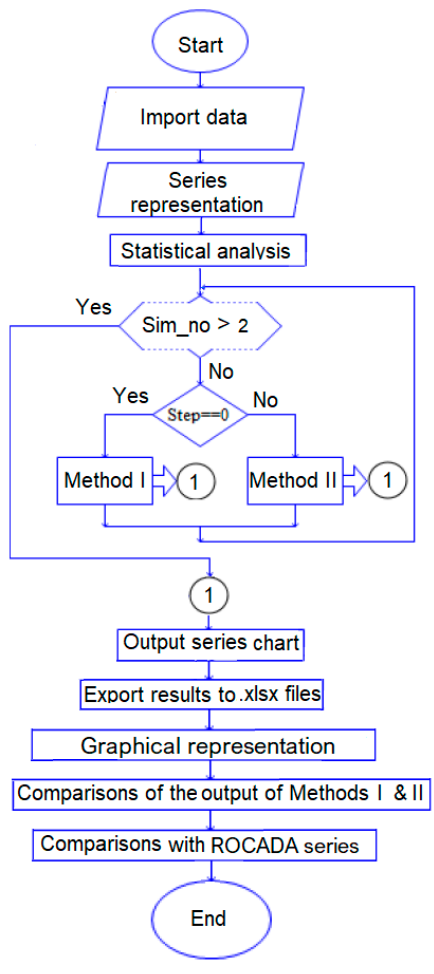
Figure 1. The study flowchart. Sim_no means the number of simulations. Two statistical tests were performed on the data series. The first one was the Mann– Kendall trend test [45] that permits testing the null hypothesis of no monotonic trend, H 0 , against the alternative hypothesis, H 1 , that there is an increasing or decreasing mono- tonic trend of the temperature series. Sen’s nonparametric procedure [46] was used to estimate the slope of such a trend (if it exists). The second test was that of Kruskal and Wallis [47], whose null hypothesis is that the distribution functions from which the samples are extracted are the same. In this case, the samples were the temperature series recorded at each site. Given k data series, each of them formed by m elements, let X = ( x ji ) ( j = 1, . . . , m , i = 1, . . . , k ) the matrix whose columns are the series elements (column 1—the elements of series 1, . . . , column k —the elements of the series k ). For determining the spatial trend, the